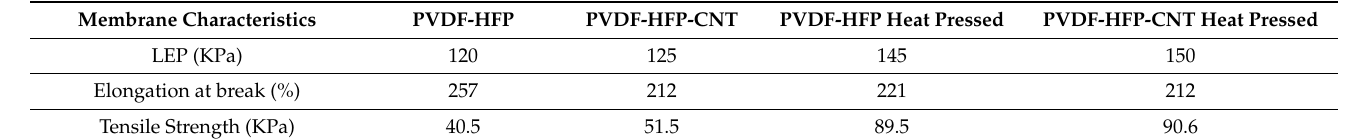
Table 3. LEP and tensile characteristics of the PVDF-HFP and PVDF-HFP-CNT membranes before and after heat pressing.